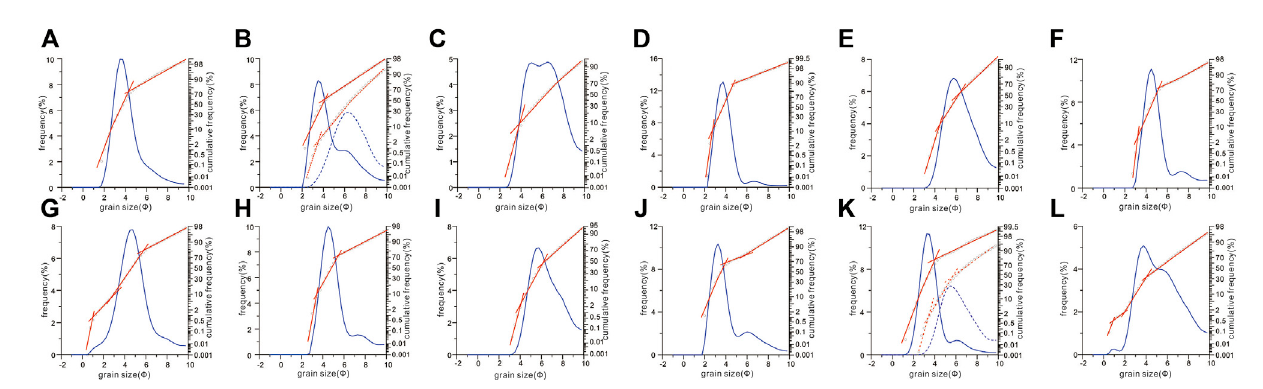
FIGURE 4 Grain size frequency (blue curve) and accumulation curves (red polyline) of typical sedimentary facies in the Jiangsu coastal plain and radial tidal sand ridges. (A) River channel at a depth of 25.55 m in the core JSWZK11; (B) fl oodplain at depths of 36.65 m (solid) and 40.75 m (dotted) in the core JSWZK04; (C) lacustrine bog at a depth of 15.35 m in the core JSWZK01; (D) tidal river channel at a depth of 26.45 m in the core JSWZK01; (E) supratidal fl at at a depth of 1.75 minthecoreJSWZK01; (F) tidal fl atatadepthof4.45 minthecoreJSWZK02; (G) lagoonatadepthof5.65 minthecoreJSWZK01; (H) deltafrontat a depth of 1.25 m in the core JSWZK10; (I) prodelta at a depth of 4.25 m in the core JSWZK08; (J) tidal sand ridge at a depth of 16.35 m in the core JSWZK02; (K) tidal sand fl ank at depths of 20.55 m (solid) and 20.65 m (dotted) in the core JSWZK03; and (L) offshore at a depth of 7.45 m in the core JSWZK10.